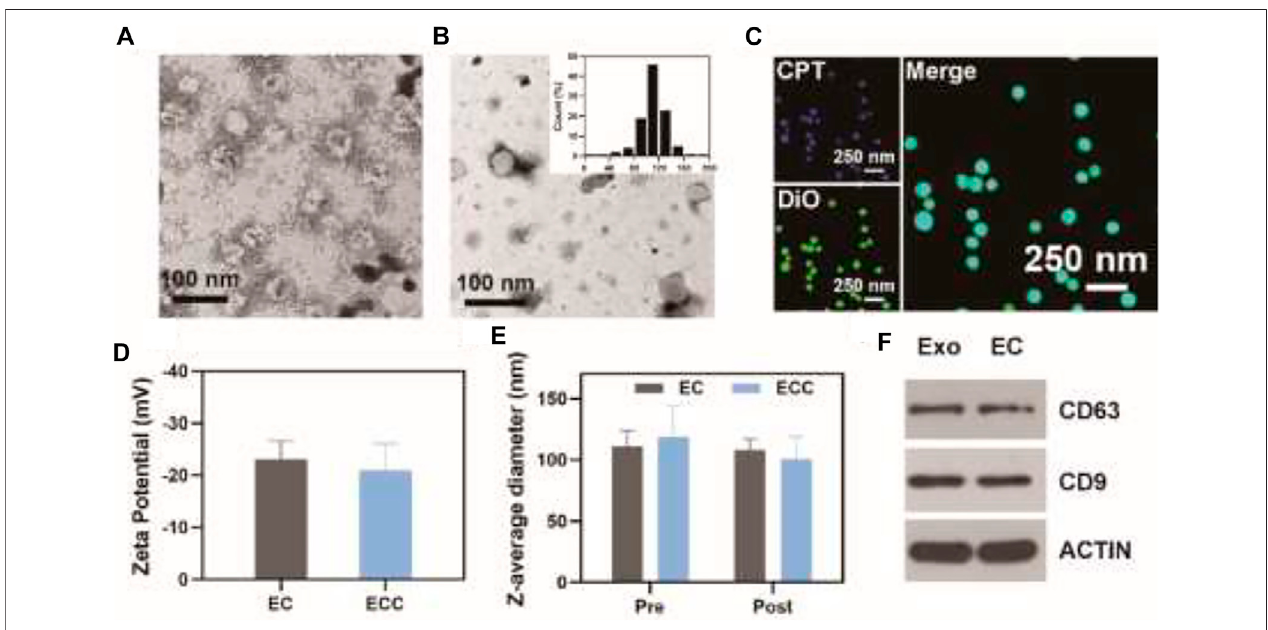
FIGURE 1 | Exosome characterization. (A) ECC and (B) EC exosomes were imaged via transmission electron microscopy, with the inset graph showing EC diameter distributions. (C) Confocal microscopic analysis ofthe colocalization ofCPT (blue) and DiO (green) withinthe EC. (D) EC and ECC Zeta potentialvalues; (E) EC and ECC Z-average diameter values before and after irradiation (6 Gy); (F) Western blotting analysis of patient-derived exosomes and